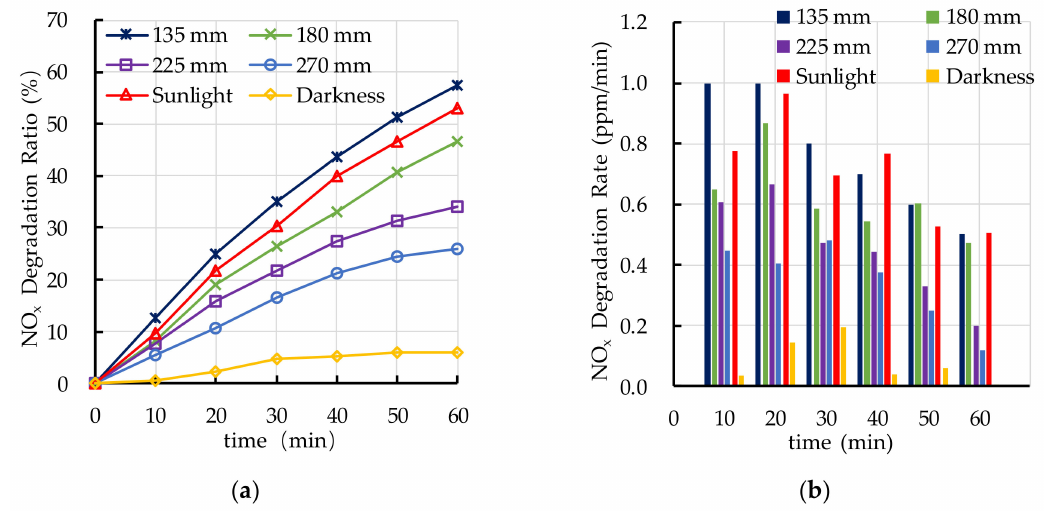
Figure 9. E ff ect of light source on photocatalytic degradation of NO x : ( a ) NO x degradation ratio; ( b ) NO x degradation rate.